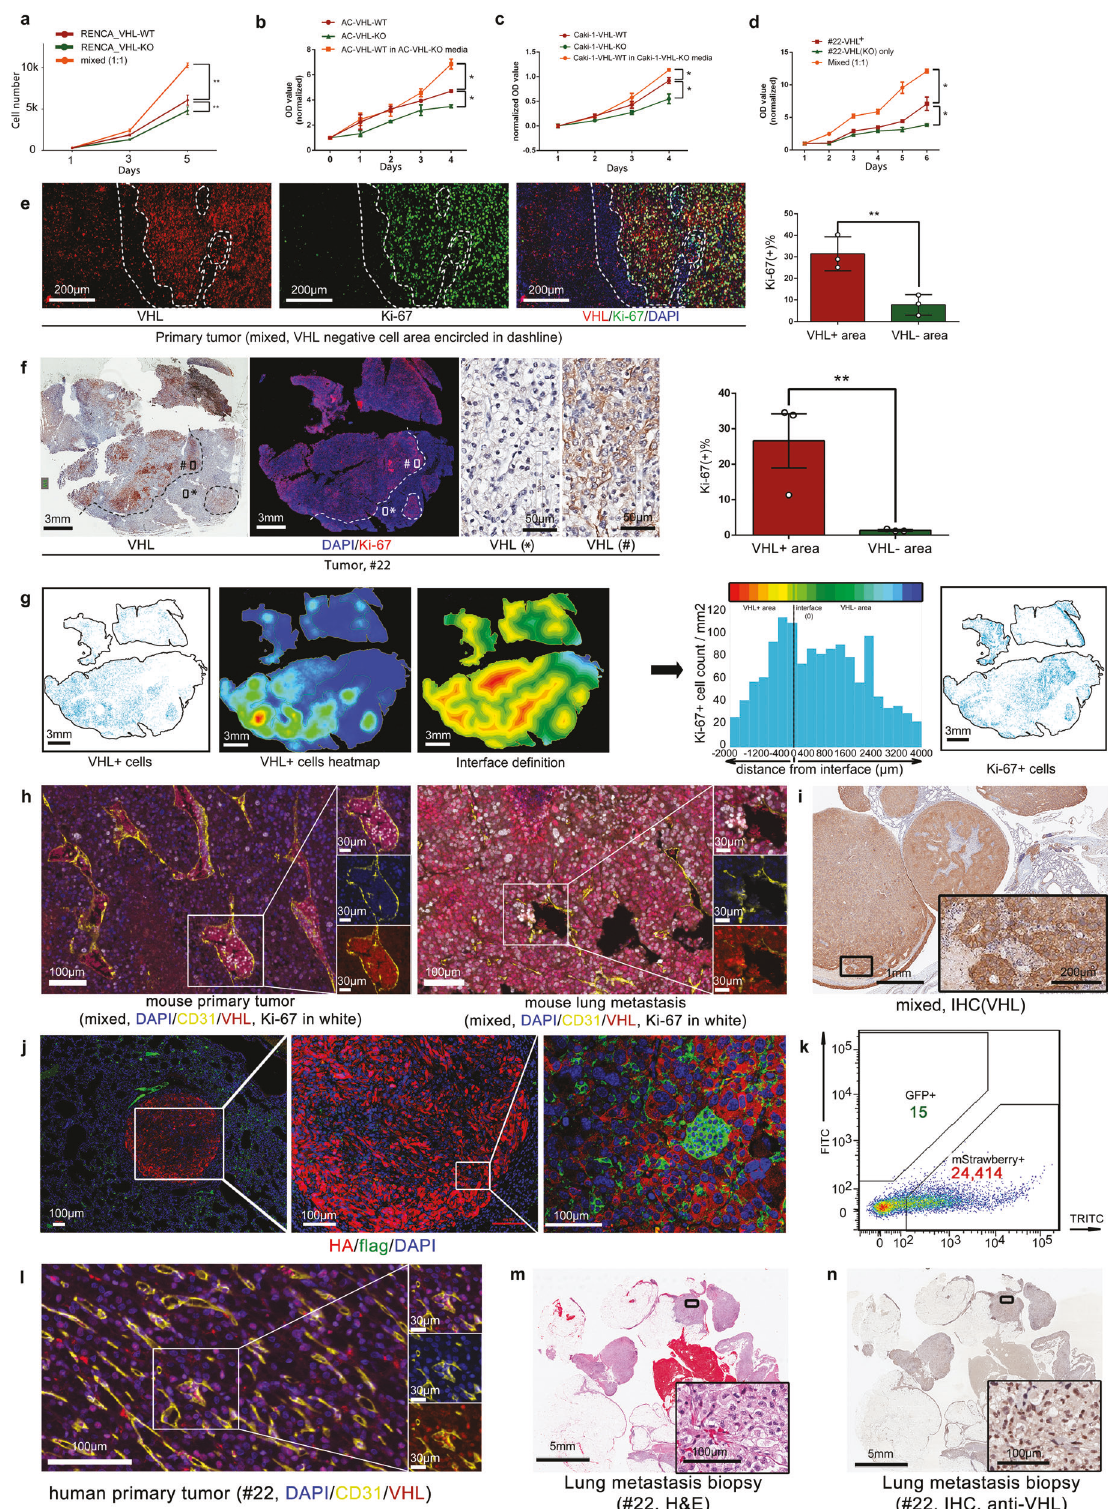
inducing the proliferation of VHL-WT or VHL +